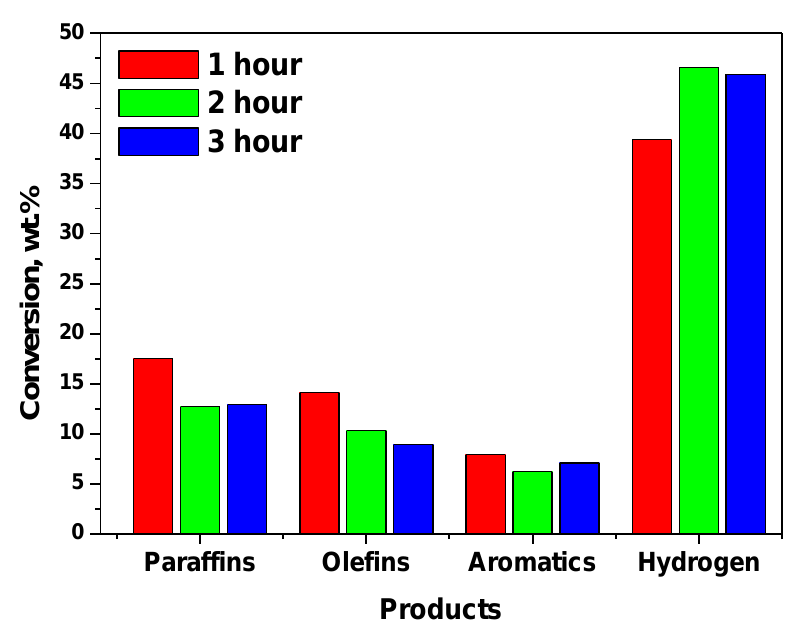
Figure 7. Selectivity of the NHYZ catalyst.